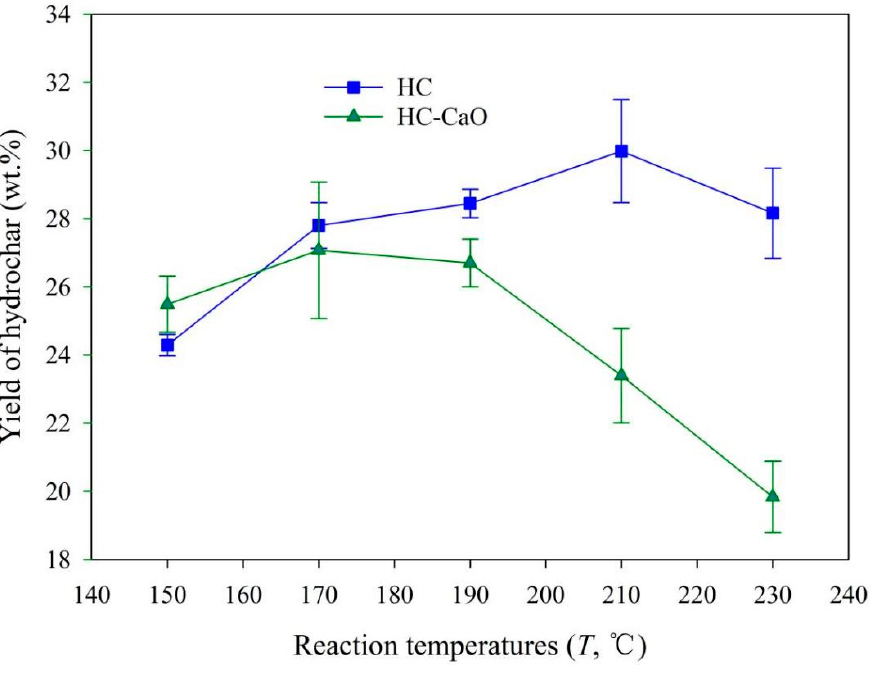
Figure 1. Yield of HC products obtained from the microwave-assisted HTC of PP.